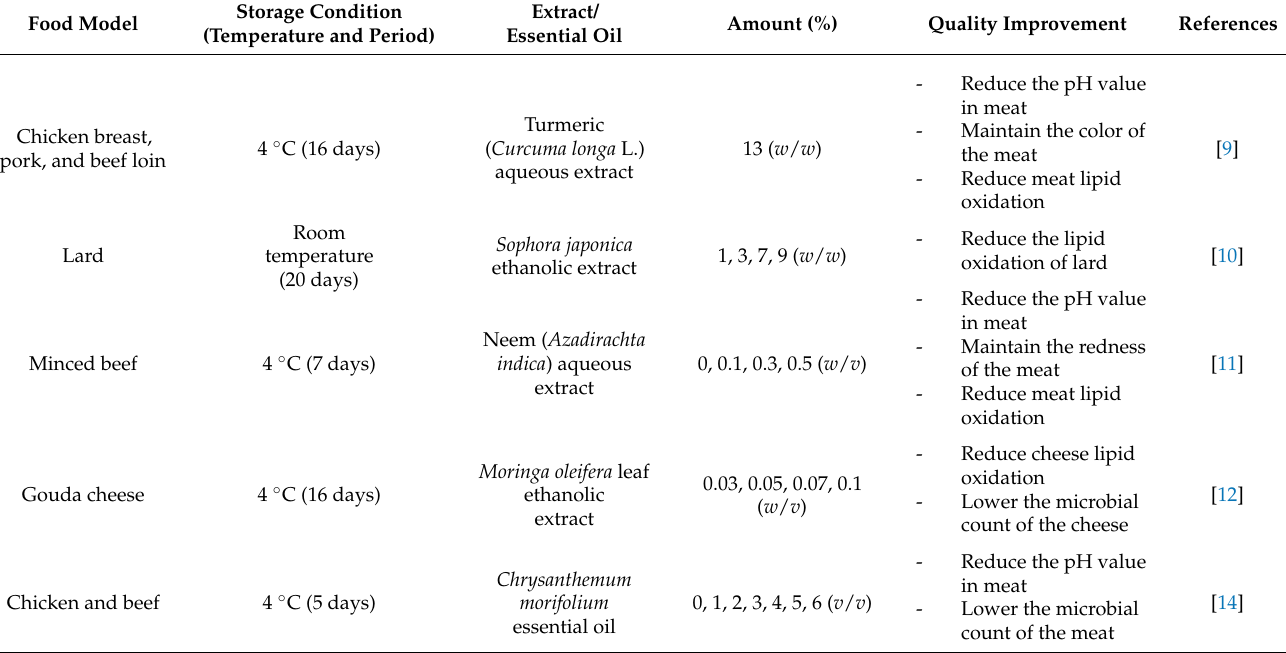
Table 4. Application, quality characteristics, and shelf life of various food models wrapped with different APE and EOs-incorporated